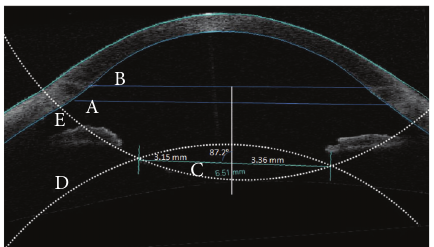
Figure 3: AS-OCT measuring lens tilt and decentration in a patient with irregular eccentric pupil. The perpendicular line posterior to the middle of the scleral spur line (A) and limbus line (B) transects the ICA-line (C). The anterior IOL curvature (D) and the posterior IOL curvature (E) were geometrically blotted to produce angles. ICA-line extends between these two angles. Lens decentration = difference between the left and right component of the transected ICA-line (3.36 mm − 3.15 mm = 0.21 mm). Lens tilt = the subtended angle deduced from 90 ∘ (90 ∘ − 87.2 ∘ = 2.8 ∘